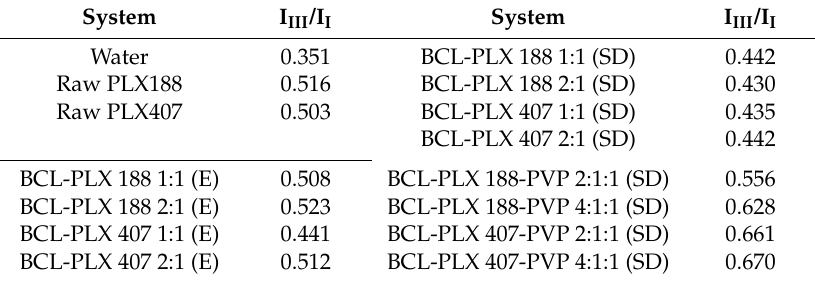
Table 3. The I III to I I ratio calculated based on the fluorescence emission spectra of pyrene solubilized in aqueous solutions of either pure compounds or solid dispersions ( λ ex = 330